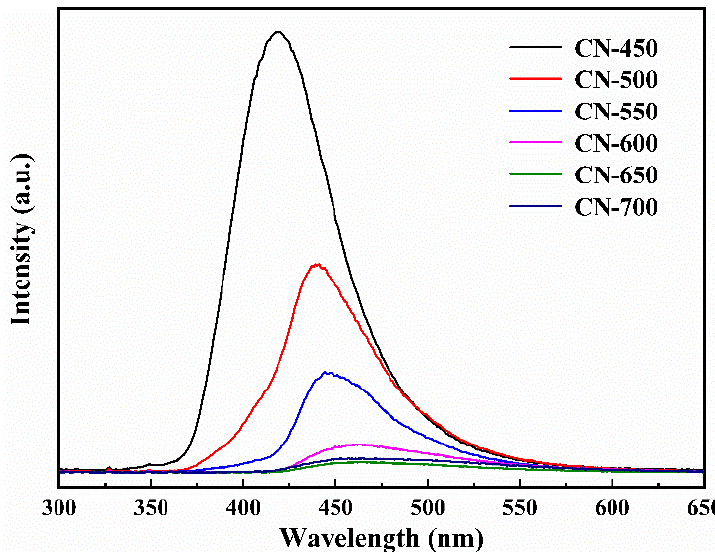
Figure 8. PL spectra of CN-450, CN-500, CN-550, CN-600, CN-650, and CN-700. The UV-vis DRS spectrum in Figure 9a shows that similar absorption edges of all the samples appeared in the visible light region. Figure 9b shows the corresponding band gaps of samples; its calculation method is referred to in the literature [37]. It was interesting to find that when the calcination temperature increased, the maximum absorption wavelength of the CN-X sample had a red shift. Its band gap gradually decreased ( E gCN-450 = 2.81 eV, E gCN-500 = 2.75 eV, E gCN-550 = 2.72 eV, E gCN-600 = 2.61 eV), the visible light absorption range correspondingly extended, which made the sample easier to be excited by visible light. While as the temperature was further increased, the flaky structure in the CN became smaller due to the high-temperature decomposition of the sample, and the subsequent quantum confinement effect made the fluorescence emission wavelength blue shifted [38], leading to a slight increase in the band gap ( E gCN-650 = 2.66 eV, E gCN-700 = 2.69 eV).